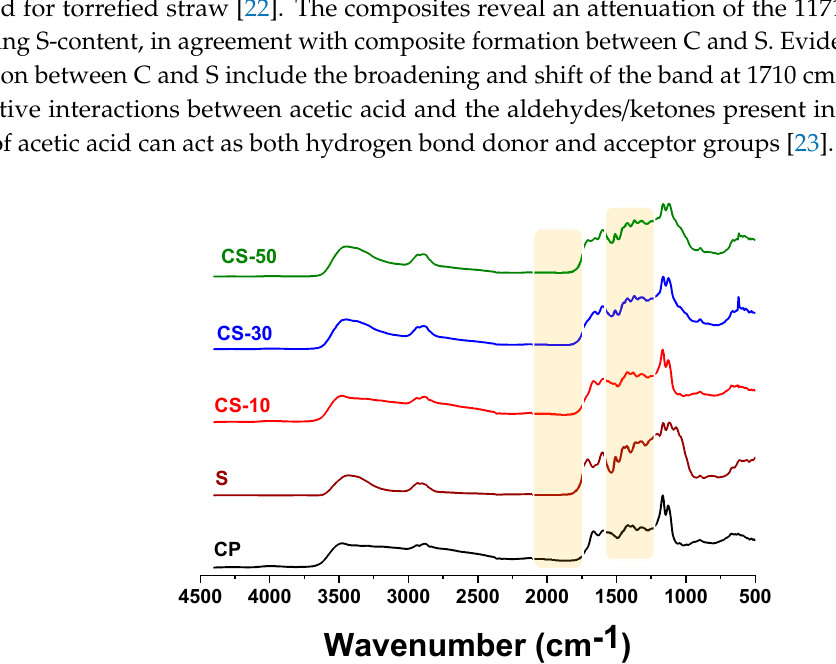
Figure 1. FT-IR spectra for chitosan pellet (CP), pristine straw (S), chitosan-straw (CS-10, CS-30, and CS-50) composite samples at variable composition.